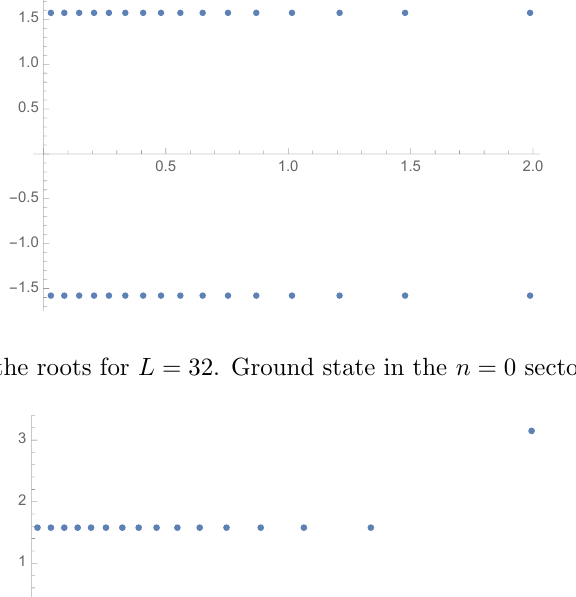
Figure 15 . Bethe roots for L = 32. First excited state in the n = 0 sector with (cid:13) = (cid:25)